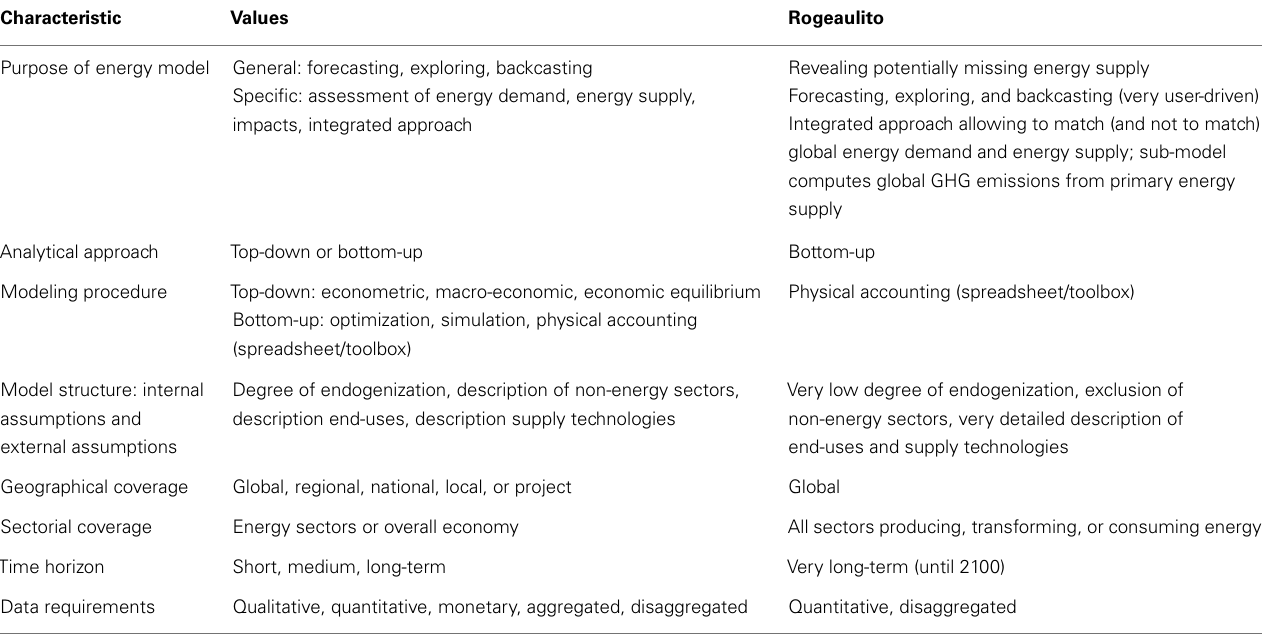
Table 1 | Rogeaulito in the energy model taxonomy